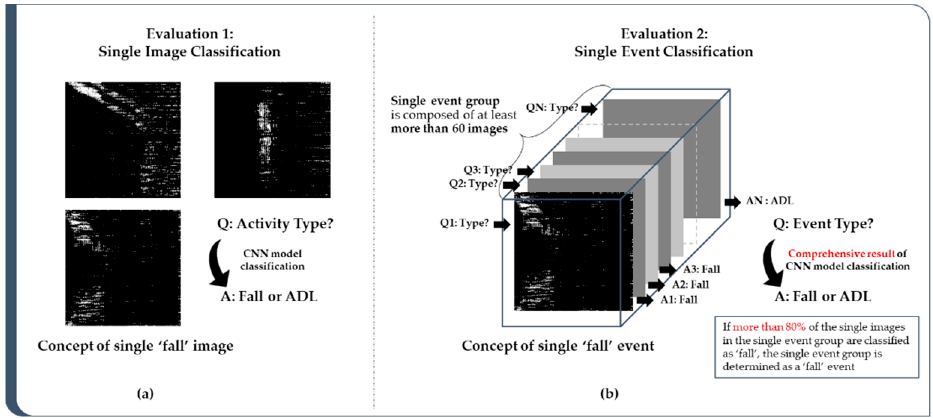
ff erence between ( a ) single image classification and ( b ) single event Figure 9. Concept difference between ( a ) single image classification and ( b ) single event classification. Figure 9. Concept di